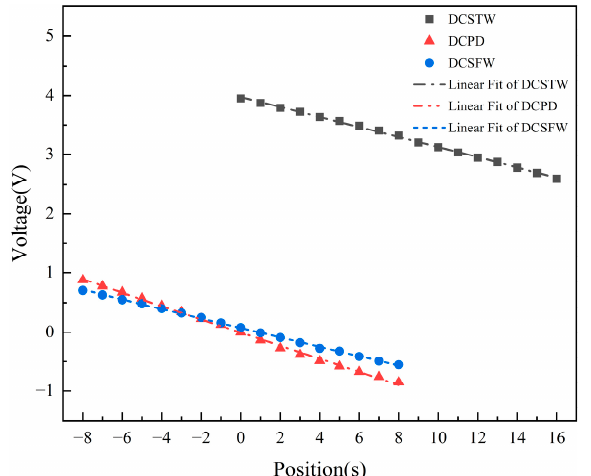
Figure 16. Comparison of the output signal with the three excitation methods (after